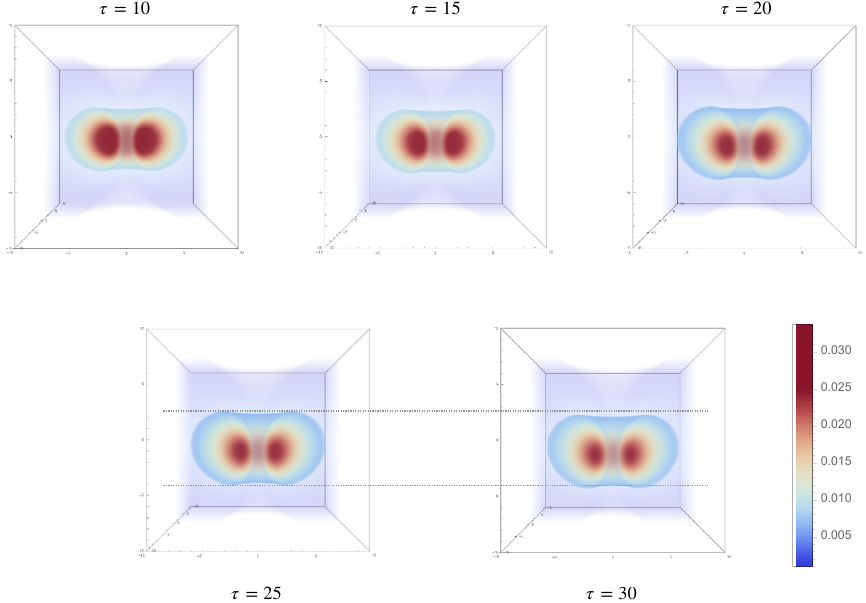
Figure 4 . Snapshots of j ~B j 2 at (cid:28) = 10 ; 15 ; 20 ; 25 ; 30. The plots are cut at y = 0. Two horizontal dotted lines are shown to indicate the position of the monopole at (cid:28) = 25. It slowly moves down being pulled by the downside Z